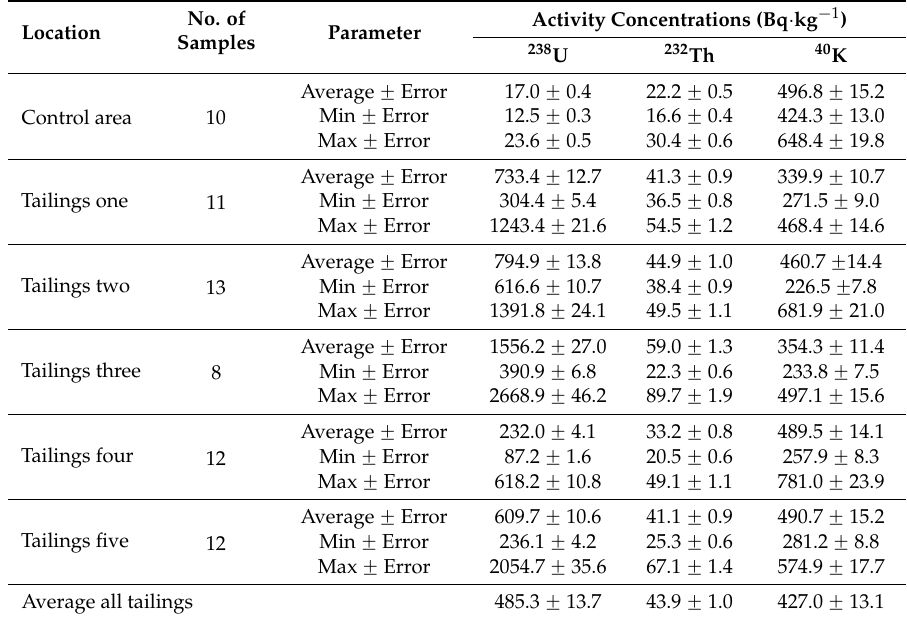
Table 1. Activity concentrations of 238 U, 232 Th and 40 K for soil samples from the mine tailings and from the control area.